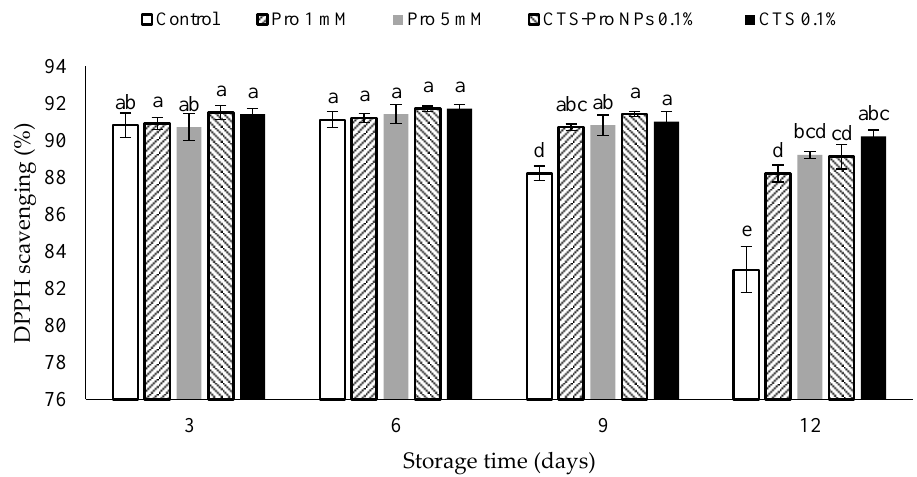
Figure 5. Effect of post–harvest treatments of strawberries with Pro, CTS and CTS–P NPs on antiox- idant capacity (%) during 12 days of cold storage at 4 °C. Data presented are mean ± SE of three replications. Different letters (a–e) over bars indicate they are significantly different ( p < 0.05) by Duncan’s test.